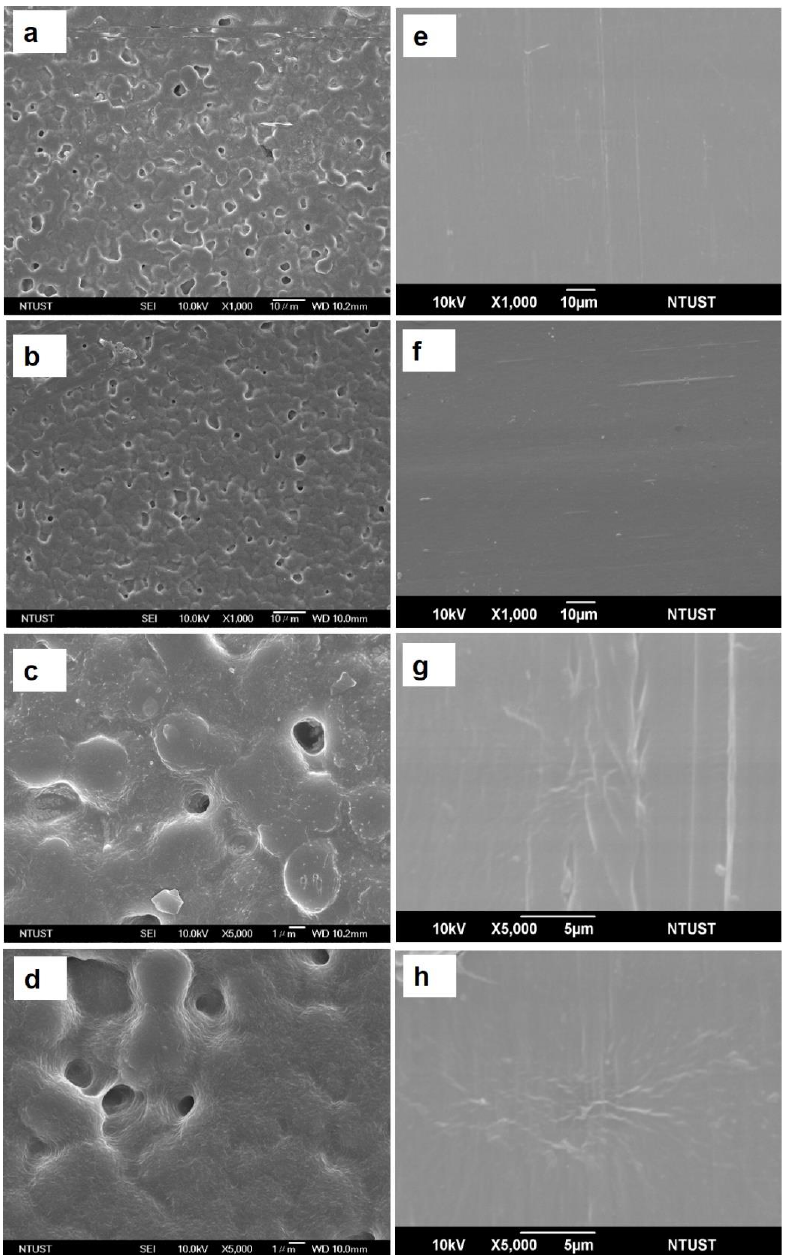
Figure 3. SEM images of a PVDF film formed by solution casting at ( a ) 90 °C and 1000×, ( b ) 100 °C and 1000×, ( c ) 90 °C and 5000×, and ( d ) 100 °C and 5000×; and by MDO at ( e ) 90 °C and 1000×, ( f ) 100 °C and 1000×, ( g ) 90 °C and 5000×, and ( h ) 100 °C and 5000×.